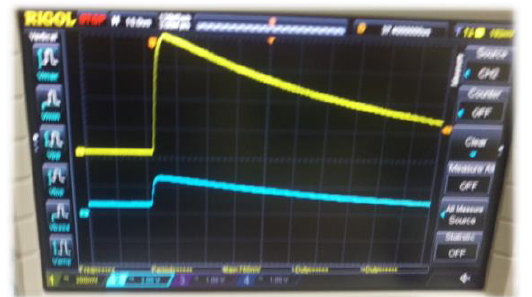
Fig. 5. The current and voltage waveform seen on the